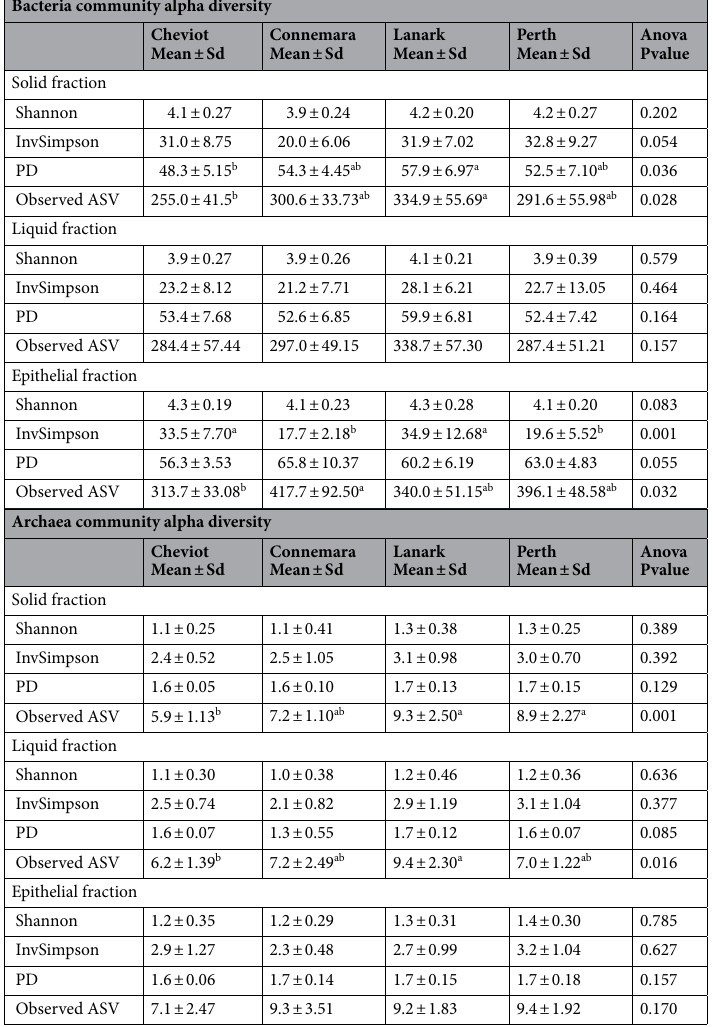
Table 2. Alpha diversity analysis. Measures of alpha diversity (Shannon, Simpson, Phylogenetic diversity and Observed ASV) for bacterial and archaeal communities, Mean ± Sd. Effect of breed on alpha diversity measures tested using two way ANOVA. Solid (Cheviot n = 8, Connemara n = 5, Lanark n = 9, Perth n = 7), liquid (Cheviot n = 9, Connemara n = 5, Lanark n = 9, Perth n = 5), epithelial (Cheviot n = 9, Connemara n = 3, Lanark n = 6, Perth n =